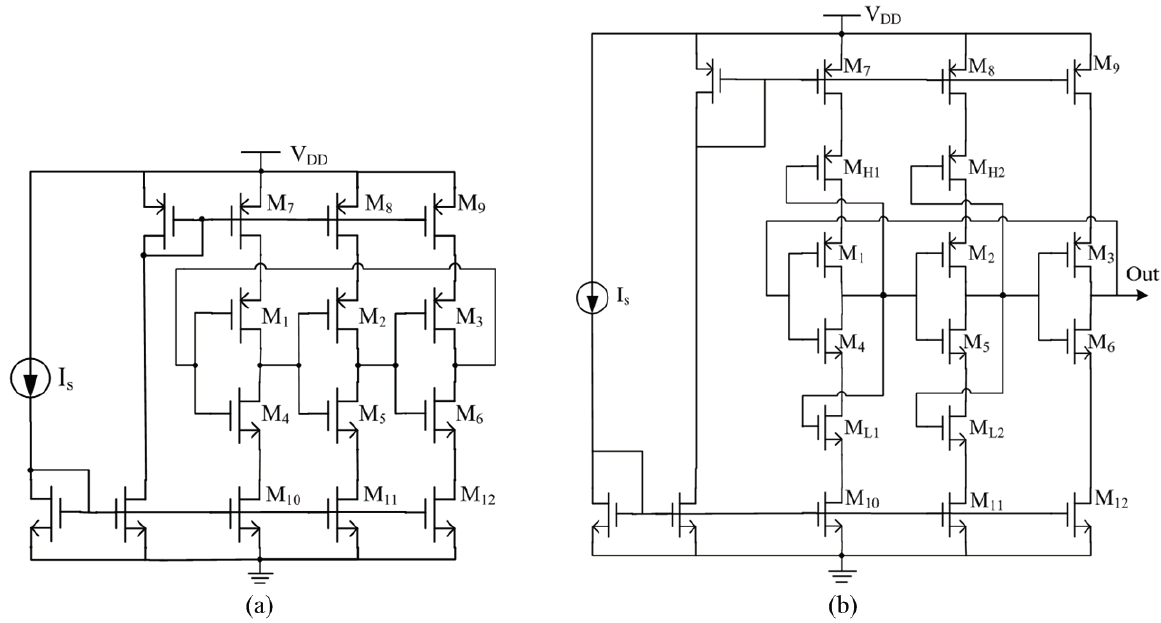
Figure 5. Current-starved ring oscillator; ( a ) conventional schematic; ( b ) proposed schematic.